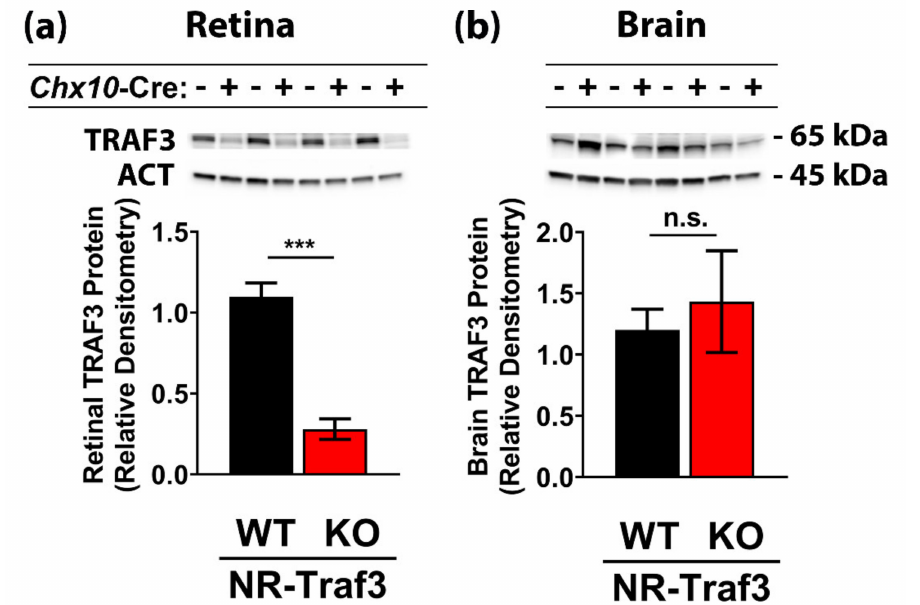
Figure 2. NR- Traf3 KO mice exhibit significant and specific reductions in whole retinal tissue TRAF3 protein. TRAF3 Western blot data and corresponding quantitative densitometry analysis for neuronal whole retinal ( a ) and brain ( b ) tissues extracts, respectively. β -actin was used as loading control and for normalization of TRAF3 protein expression. To detect protein within the linear range of the assay, protein loads were as follows: retinal TRAF3, 25 µ g; brain TRAF3, 60 µ g; retinal/brain β -actin, 10 µ g. Chx10 -Cre negative ( − ) and positive (+) expression indicate NR- Traf3 WT and KO mice, respectively. Data are the mean ± SEM and were analyzed via Student’s t -test (*** p < 0.001; n =